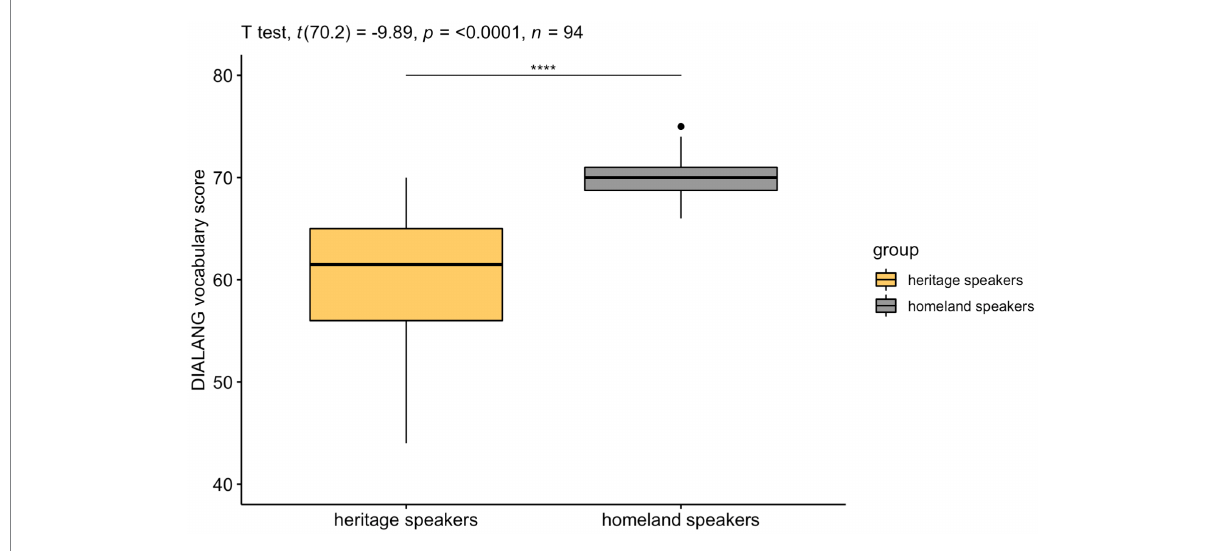
FIGURE 1 Heritage and homeland speakers’ scores on the Italian vocabulary test DIALANG (raw